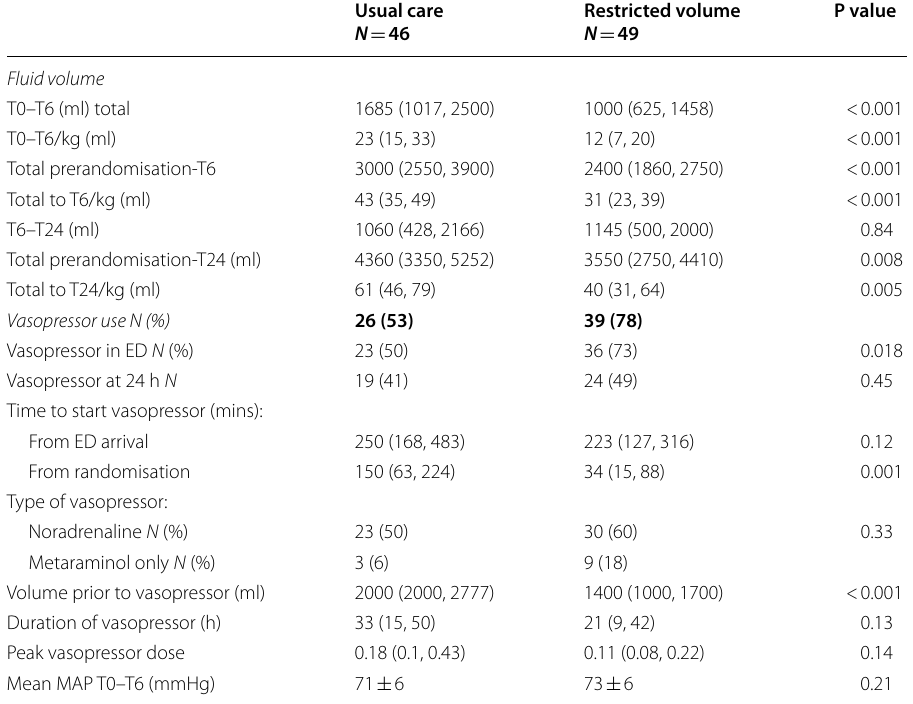
Table 2 Fluid and vasopressor